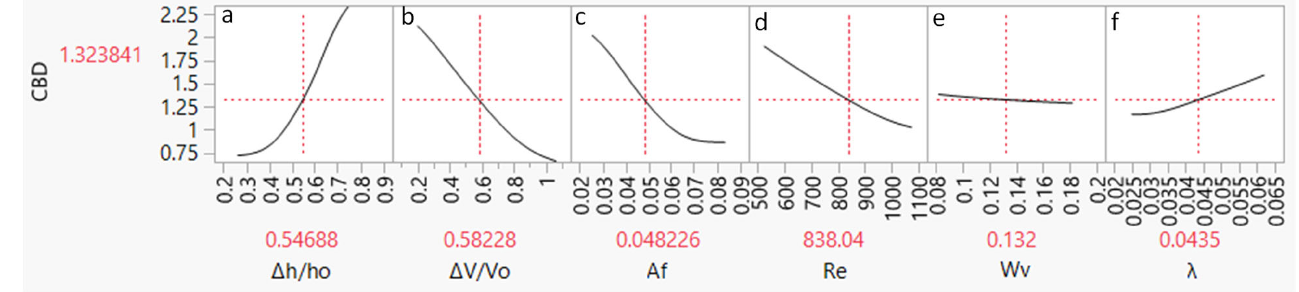
Figure 8. Predicted values of the bulk drag coefficient against variables; ( a ) ∆ h/h o , ( b ) ∆ V/V o , ( c ) A f , ( d ) R e , ( e ) W v and ( f ) λ .